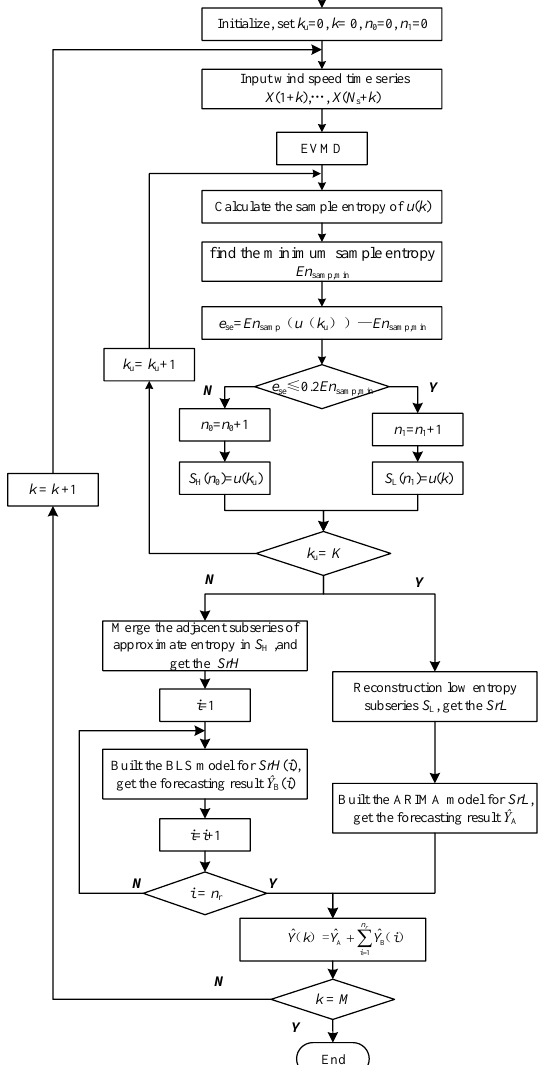
Figure 6. Flowchart of EVMD-SR-BLS-ARIMA for ultra-short-term wind speed forecasting.